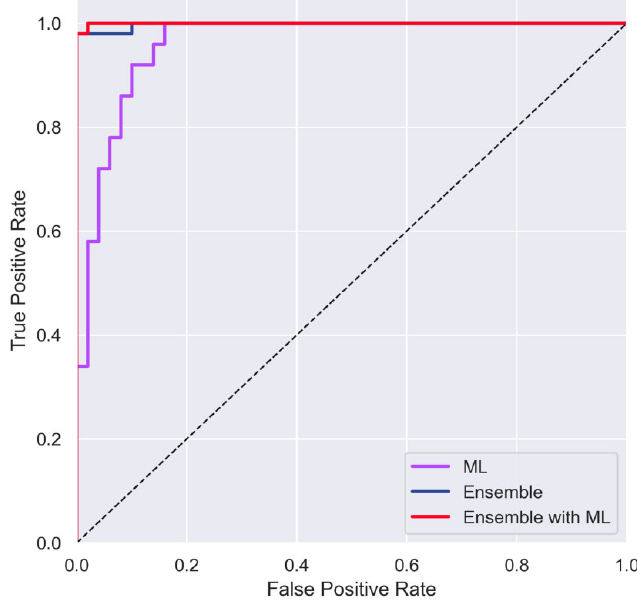
Figure 10. Diagnostic performances of the ML (purple), ensemble (blue), and ensemble with ML (red) models. The diagnostic performances of the ML, ensemble, and ensemble with ML models were 0.962 (95% CI, 0.922–1.000), 0.998 (95% CI, 0.989–1.000), and 0.999 (95% CI, 0.996–1.000), respectively. The diagnostic performance was significantly greater in the ensemble model with ML than in both ML and ensemble models ( p < 0.001). Abbreviations: ML, machine learning; CI, confidence interval.